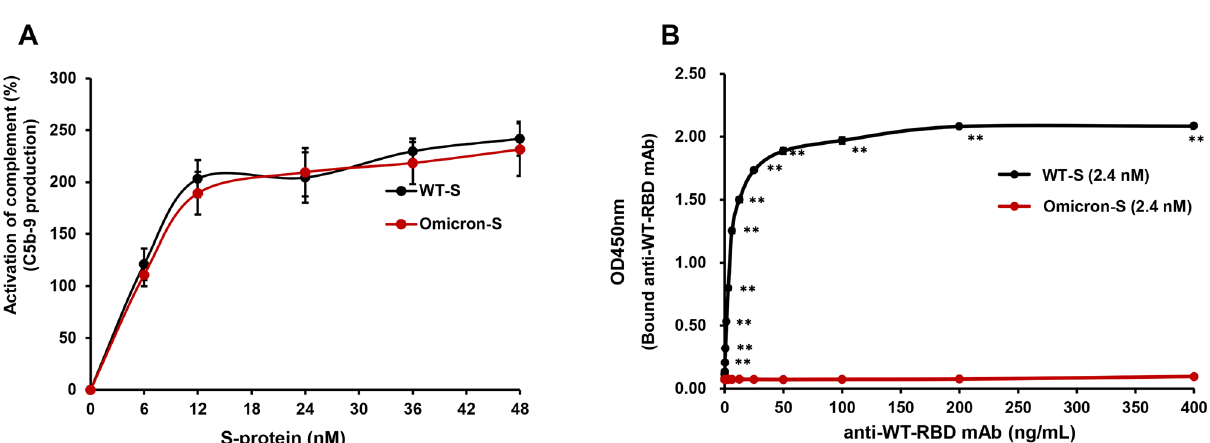
Figure 4. Comparison of the ability of trimer WT-S and Omicron-S to activate complement and bind to anti-WT-RBD mAb. ( A ) Comparison of the ability of trimer WT-S and Omicron-S to activate complement. Normal human serum complement was added into the plate coated with trimer WT-S or Omicron-S at different concentrations (0–48 nM). After 1 h incubation, complement activation was terminated by washing the plate four times. The produced membrane attack complex C5b-9 was combined with a mouse anti-human C5b-9 IgG2b antibody which further combined with an HRP-conjugated goat anti-mouse IgG antibody. The chromogenic reaction was developed by adding TMB substrate and then terminated by 2 M H 2 SO 4 . OD values at 450 nm , which were positively correlated with the C5b-9 production, were determined. Activation percentage of complement was calculated relative to the negative control. Mean ± SD (n = 3). ( B ) Comparison of the binding ability of two trimer S-proteins to anti-WT-RBD mAb. The purified anti-WT-RBD mAb at different concentrations was added into the plate coated with 2.4 nM of trimer WT-S or Omicron-S. After 1 h incubation, the unbound mAb was washed away by PBST and the bound mAb could be detected by HRP-conjugated goat anti-mouse IgG. The chromogenic reaction was developed by adding TMB substrate and then terminated by 2 M H 2 SO 4 . OD values at 450 nm , which were positively correlated with the binding ability (affinity) of S-protein to anti-WT-RBD mAb, were determined. Mean ± SD (n = 3). ** P < 0.01 vs .